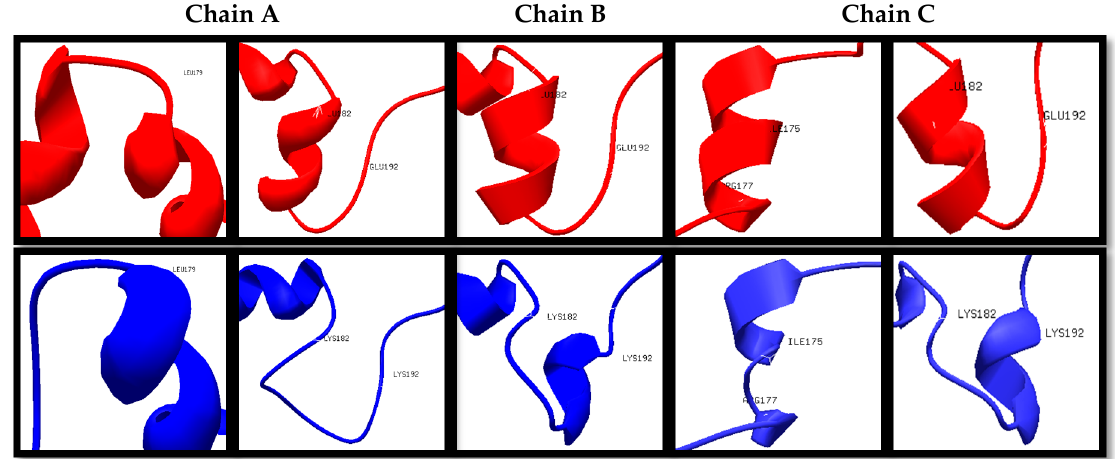
Figure 1. Structural differences of specific amino acid residues (red: Wt; blue: Mut2) .